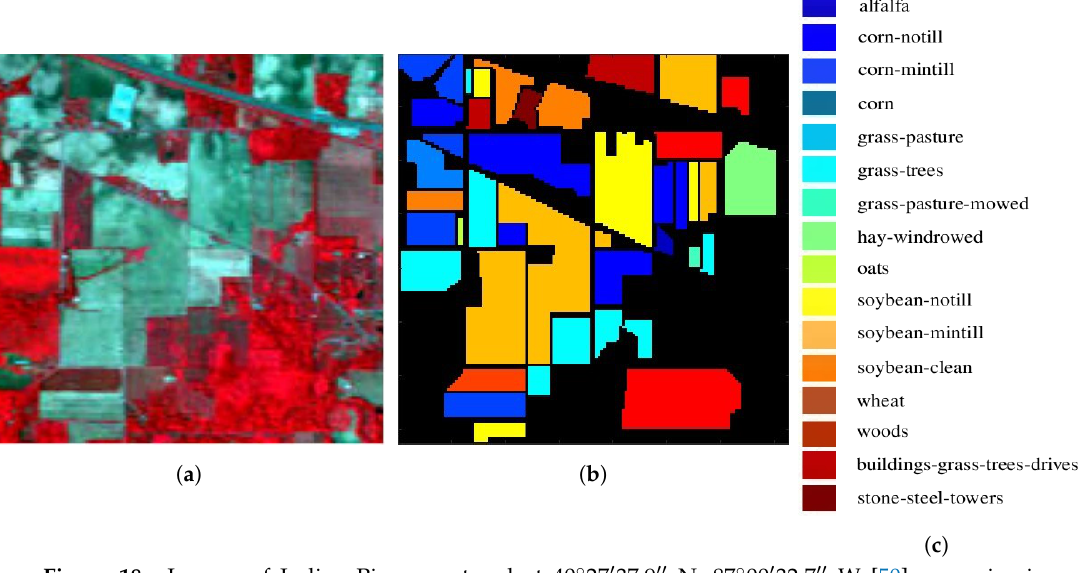
Figure 18. Images of Indian Pines, centered at 40 ◦ 27 (cid:48) 37.9 (cid:48)(cid:48) N, 87 ◦ 00 (cid:48) 32.7 (cid:48)(cid:48) W [50], area size is 3.2 × 3.2 km, ( a ) false color image, ( b ) ground truth, black area is unlabeled, ( c ) legends of 16 classes. Table 3. Summary of ground truth in Figure 18